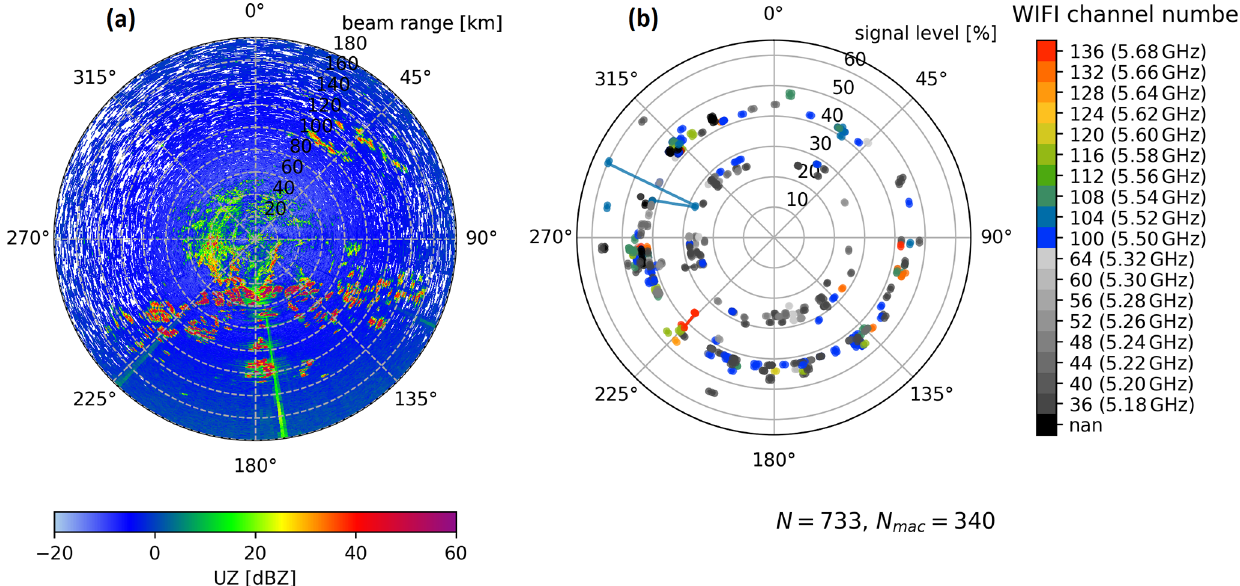
Figure 6. An uncorrected reflectivity (UZ) PPI is shown in panel (a) from the radar site ISN. It was taken after the RHunt sweep on 6 April 2022 at 10:27UTC. Panel (b) contains the identified Wi-Fi networks at their respective azimuth and signal level as dots. The Wi-Fi channel is colour coded. Channels above 100 (5500MHz, allowed outdoor) are coloured, and others are in greyscale. Each line connects networks with the same MAC address. In total 733 Wi-Fi records ( N ) and 340 networks with unique MAC addresses ( N mac ) were captured. Note the different variables on the radial